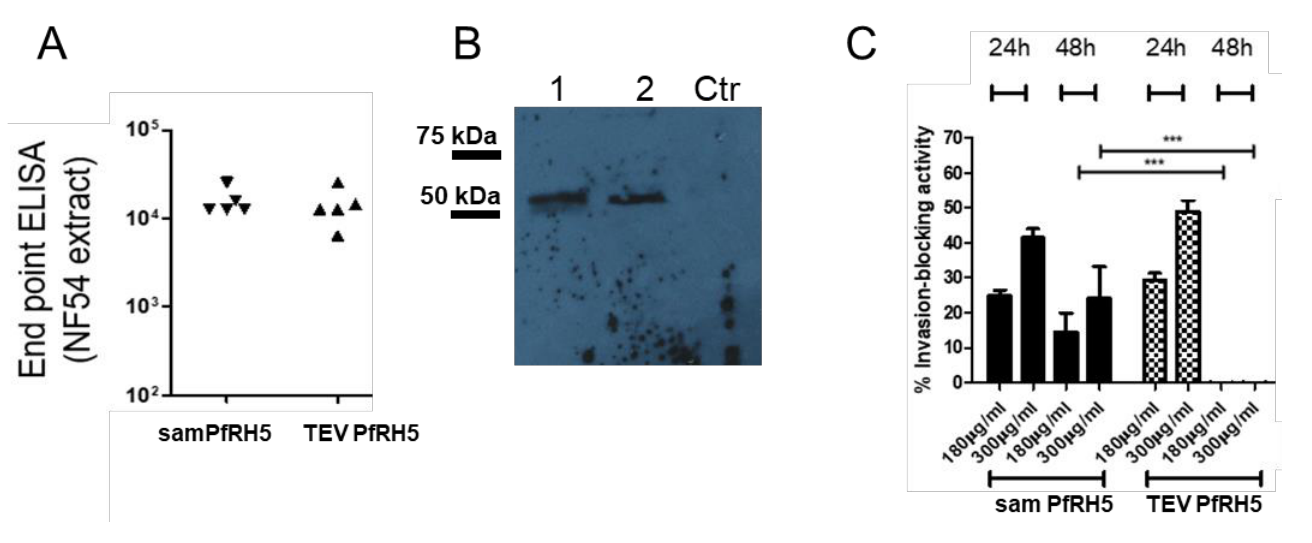
Figure 7. Sera from immunized mice recognized native PfRH5 in P. falciparum NF54 schizont extracts, and exerted an inhibitory effect in vitro. In ( A ), endpoint titers of anti-samPfRH5 and TEV mRNA PfRH5 sera were measured (titers of Log10, no statistical difference between the groups). Individual sera of 5 liposome-packaged RNA-immunized mice were tested in endpoint dilutions. For coating, ELISA plate schizont extracts were used instead of recombinant PfRH5 antigens. ( B ) Sera from samPfRH5- and TEV PfRH5 RNA-immunized mice were used to recognize extracts from P. falciparum NF54. Lane 1 is pooled sera from samPfRH5-immunized mice, lane 2 from TEV PfRH5-immunized mice, and Ctr, controls from pre-immune sera. In ( C ), the percentage of growth inhibition of parasite proliferation (measured by flow cytometry) is shown for two dilutions of purified IgGs from four mice immunized with encapsulated samPfRH5 or TEV PfRH5. The shown values were calculated by comparing parasitemias in parallel cultures supplemented with 300 µg/mL non-related IgG (=0% growth inhibition, for samPfRH5 is shown to average 26% ± 1.5 for 180 µg/mL and 43.1% ± 2.4 for 300 µg/mL in 24 h; average 214.5% ± 4.5 for 180 µg/mL and 24% ± 9.5 for 300 µg/mL in 48 h; in the case of TEV PfRH5, average of 29.4% ± 2 for 180 µg/mL and 49% ± 3.5 for 300 µg/mL). Analyses assuming equal variance and non-parametric values showed no difference between 24 h antisera from both RNA immunizations, and a large difference after 48 h of cultivation, Kruskal–Wallis test, *** = 0.0001) The values are shown for 24 h and 48 h of inhibition. See Supplementary Figure S2 for original Western blot X-ray